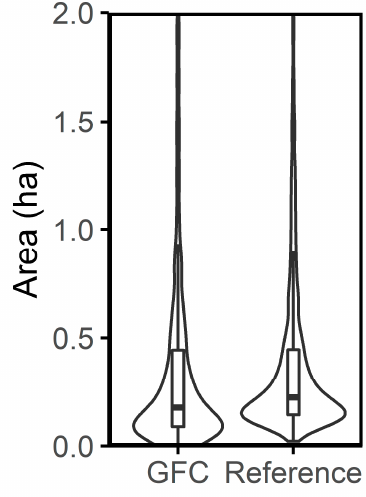
Figure 5. Comparison of violin and box plots of the distributions of areas of forest loss during 2014 to 2016 derived from the GFC and reference datasets.